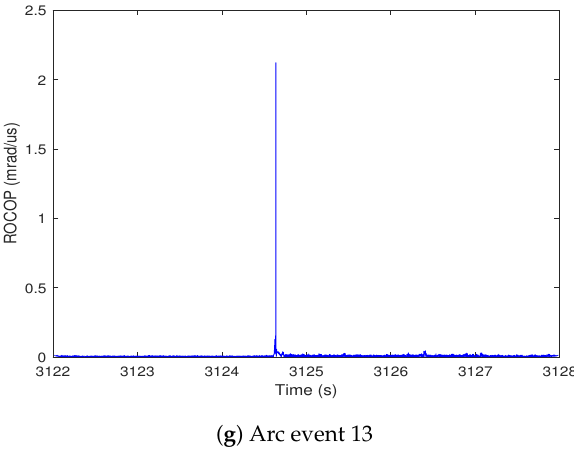
Figure 14. Absolute instantaneous ROCOP after being filtered by the MA filter for the arc events 7 to 13.